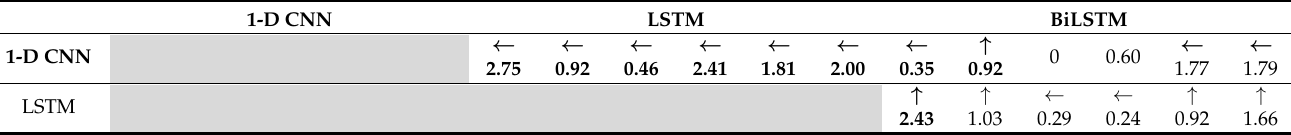
Table A3. Z scores of DL algorithms on cancer prediction. (Illustrations by the